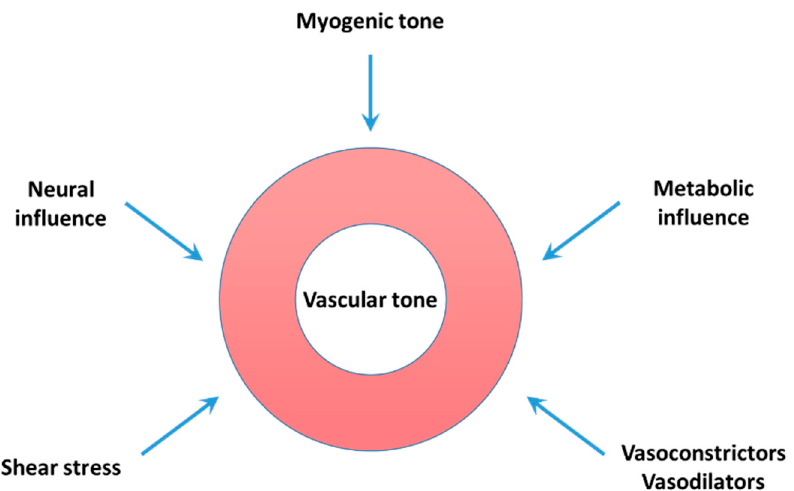
Figure 1. Vascular tone is determined by a variety of factors. Myogenic tone produced in response to intraluminal pressure changes constitutes the basal vascular tone, upon which vasoconstrictors, vasodilators and neurotransmitters released by sympathetic and parasympathetic nerves, locally produced metabolic substances and others can act to produce vasoconstriction or